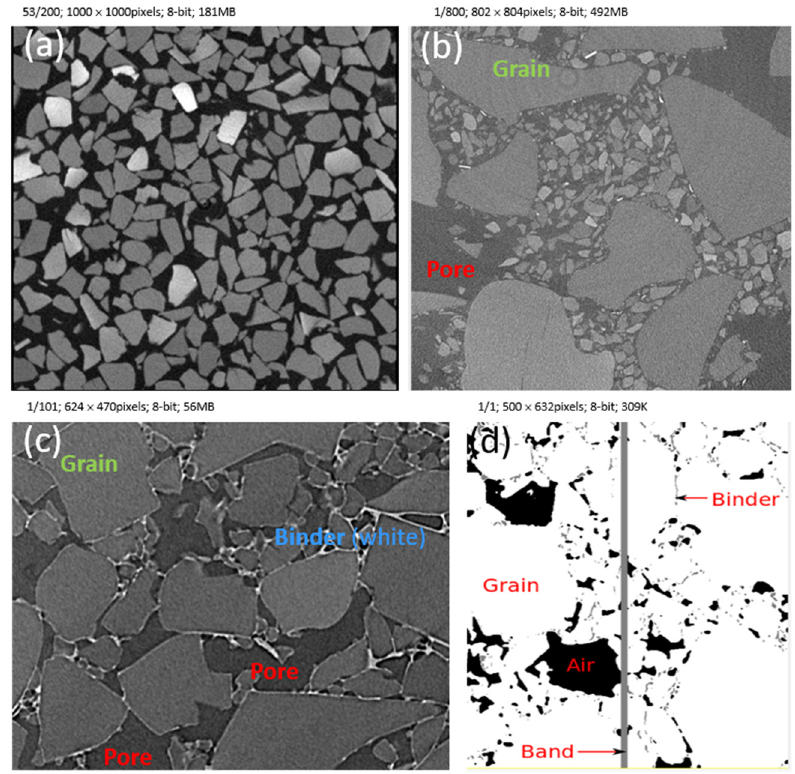
Figure 1. Tomography cross-section of aerogel composite. ( a ) Monomodal pile-up medium size grain IP = 36%; ( b ) bimodal aerogel pile up IP = 42%; ( c ) organic binder and bimodal pile-up IP = 19%; ( d ) defect simulation, binder band perpendicular to the heat flux.